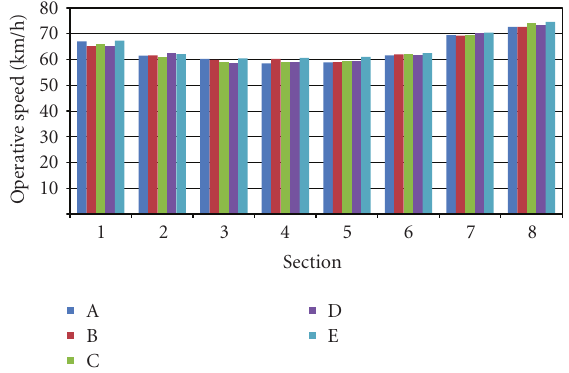
Figure 10: Speed profile in 5 di ff erent driving environments in the eastbound direction. Scenarios A (present layout), B (A + vertical signs), C (A + horizontal marking), D (A + signs + marking), and E (layout